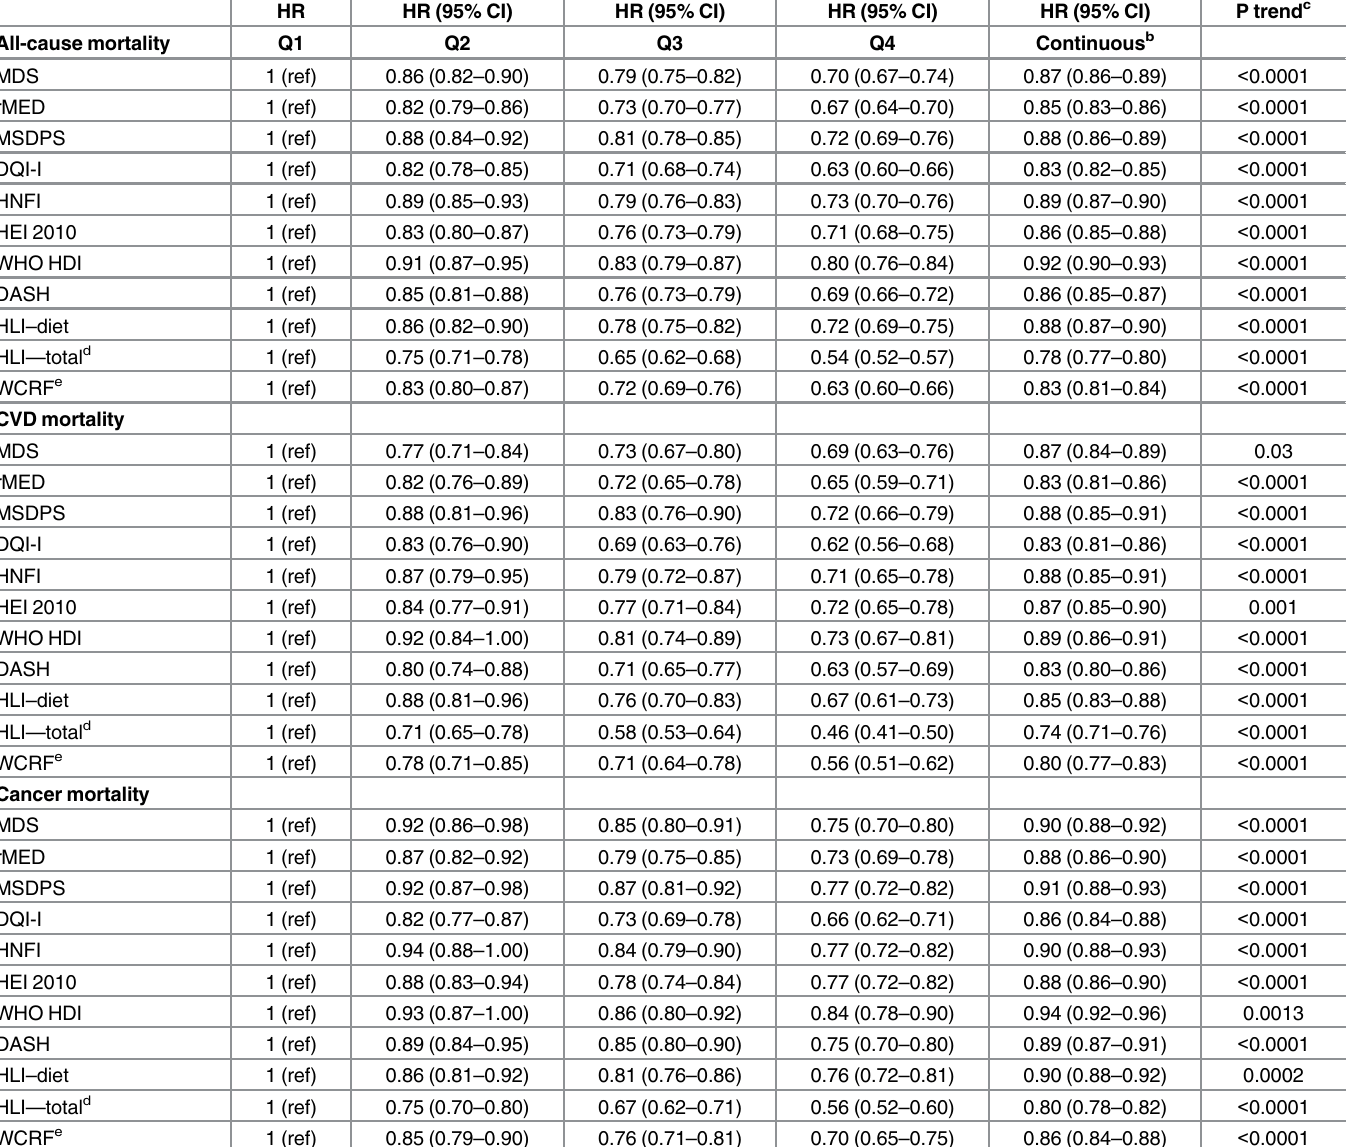
Table 3. Hazard ratios (Model 1) a for 10-year mortality risk by quartile (Q) of diet quality score and for a 1SD increase of diet quality among 451,256 participants of the EPIC